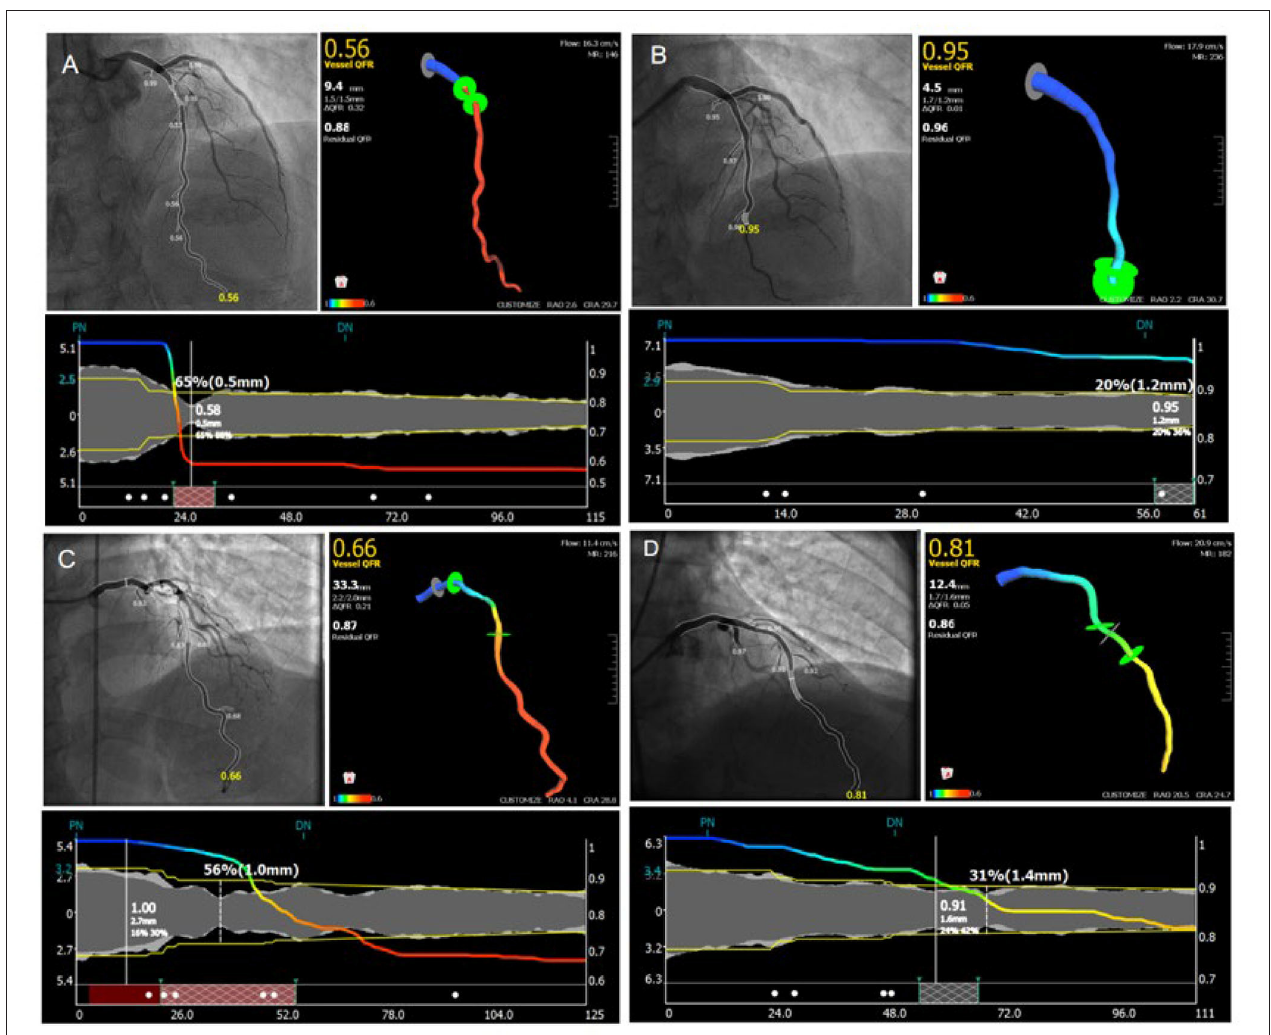
FIGURE 2 | Representative images for cQFR analysis. (A,C) Representative images for the measuring of pre-percutaneous coronary intervention quantitative flow ratio. (B,D) Representative images for the measuring of post-percutaneous coronary intervention quantitative flow